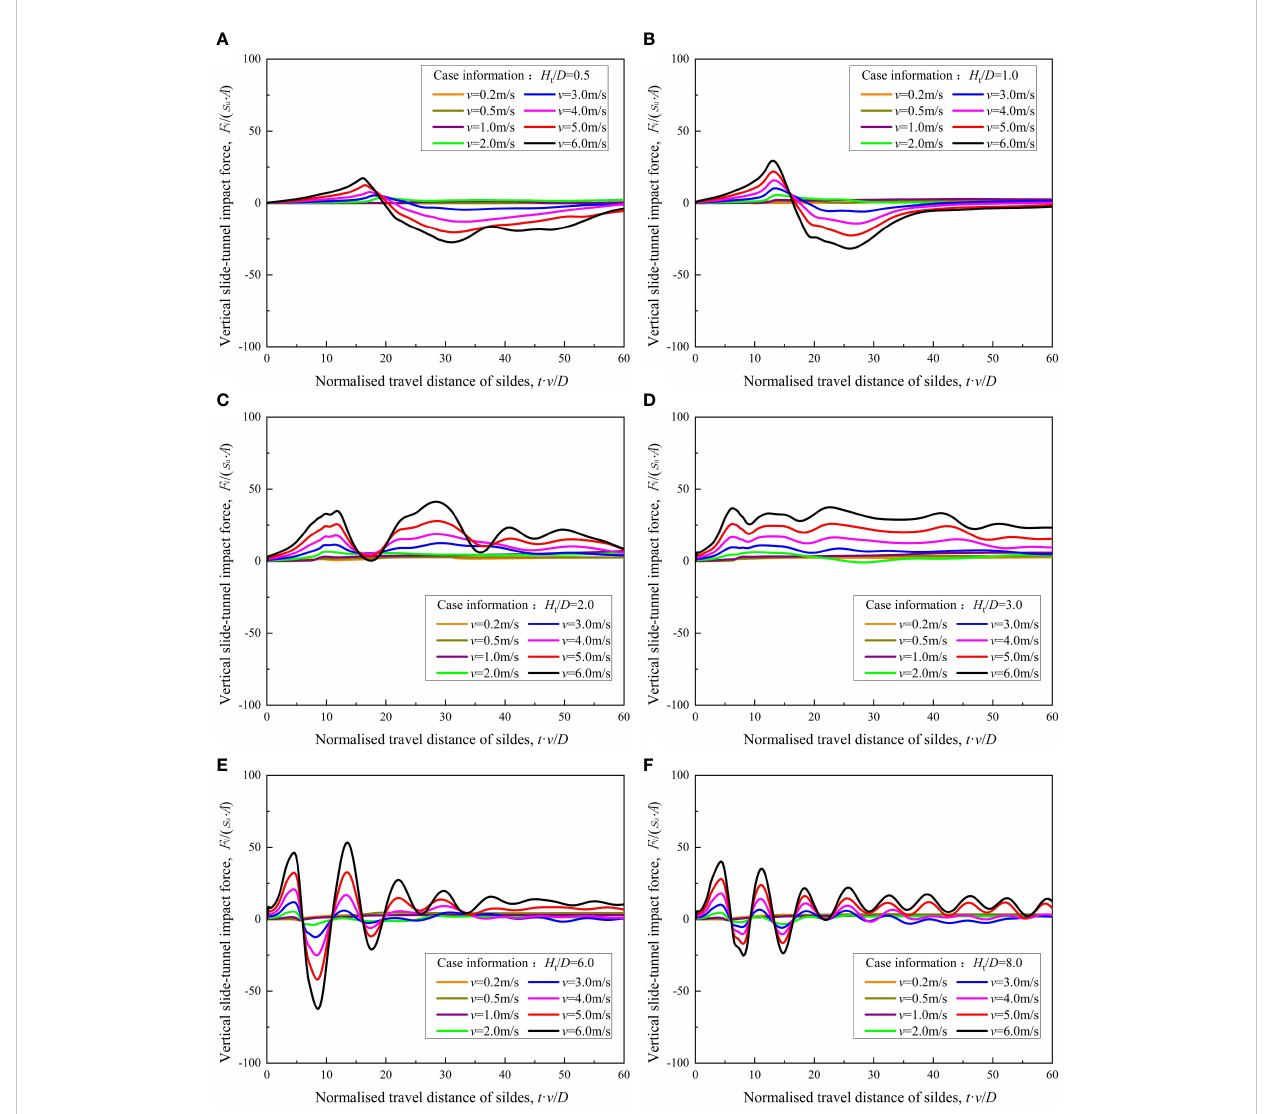
FIGURE 5 Vertical impact force curves during submarine slide-tunnel interaction at different thicknesses of slide mass (an example of the octagon section): ratios of slide mass thickness/diameter = 0.5 (A) , 1.0 (B) , 2.0 (C) , 3.0 (D) , 6.0 (E) , and 8.0 (F)